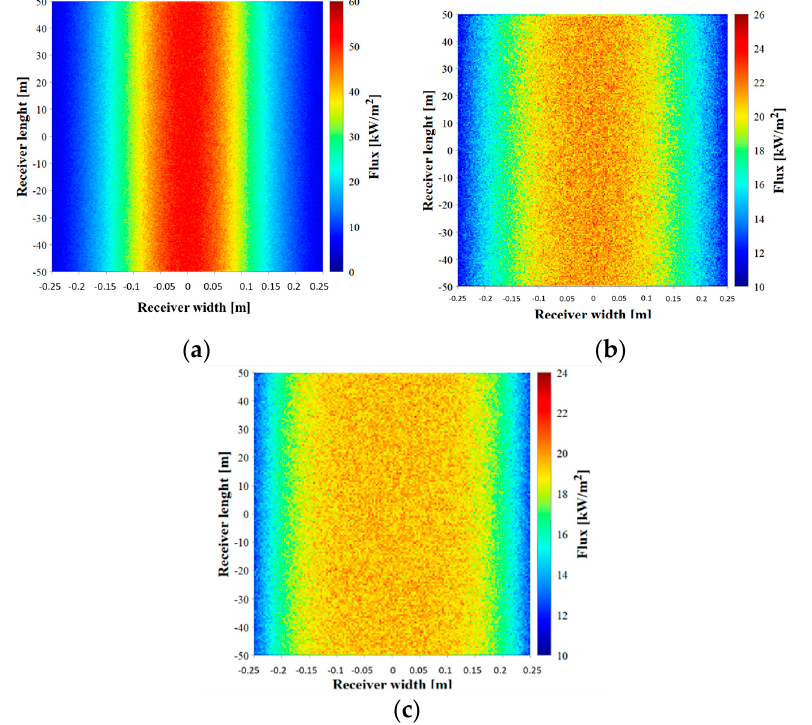
Figure 14. Flux distribution in the receiver aperture. ( a ) Parabolic trough collectors PTC. ( b ) Optimized Fresnel. ( c ) FRESDEMO.